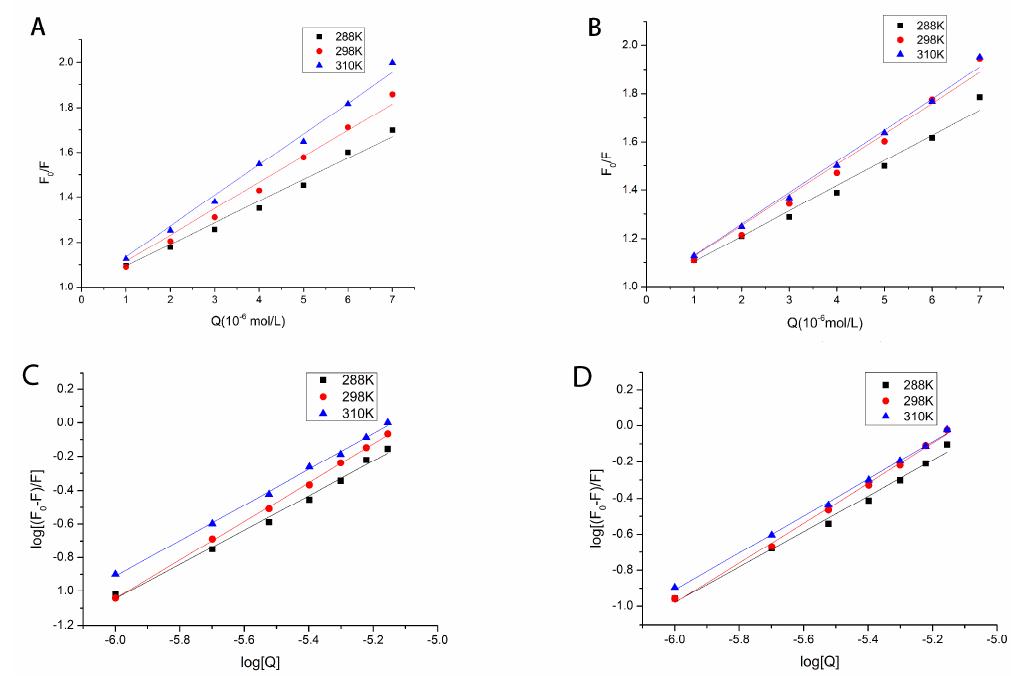
Figure 3. The Stern–Volmer plots for the quenching of HSA by TF ( A ) and GHSA by TF ( B ) at di ff erent temperatures (288 K, 298 K, 310 K). Plots of log [(F 0 − F) / F] versus log [Q] for the TF–HSA systems ( C ) and TF–GHSA systems ( D ) at different temperatures.